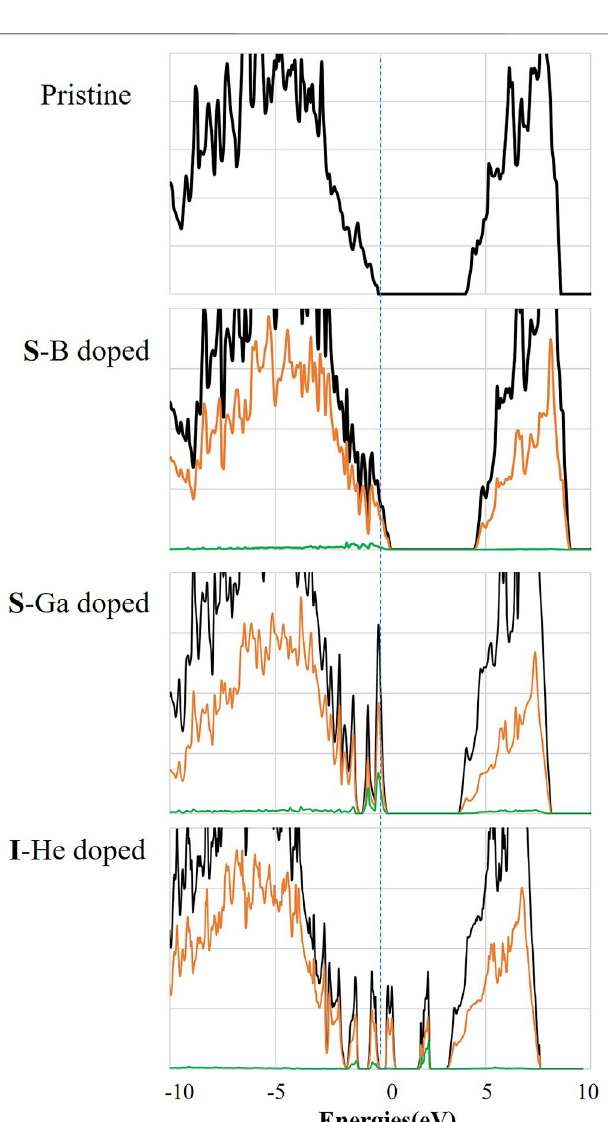
FIGURE 5 | Calculated density of states (DOS) of diamond with different dopants. (The black lines represent the total DOS; brown and green lines represent the PDOS of C atoms and the